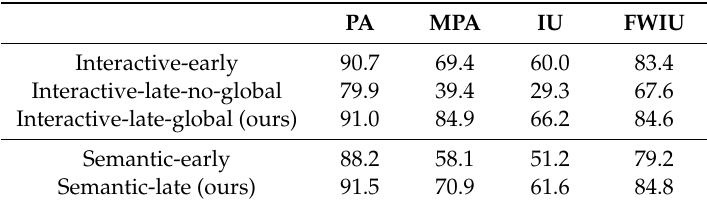
Table 3. Evaluation results under the settings of (1,3)-shot. For interactive segmentation, our interactive-late-global has a significant improvement in all four metrics, especially in IU. For semantic segmentation, our approach also has about 10% improvement in IU.